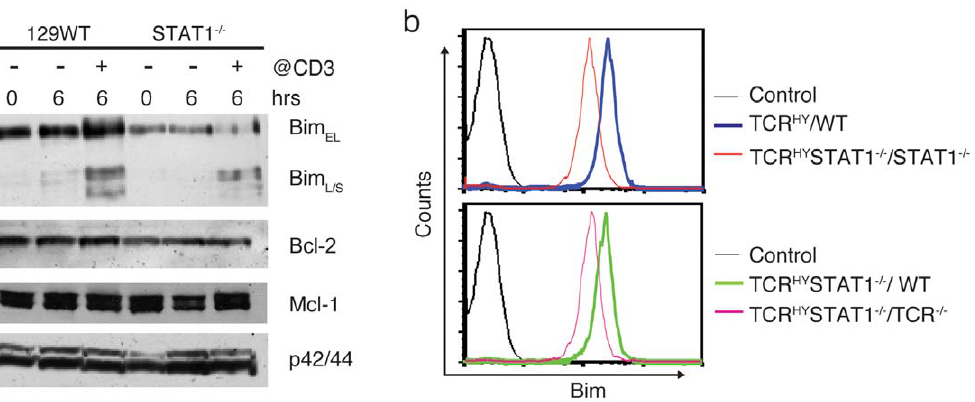
Figure 5. Bim expression correlates with altered elimination of STAT1-deficient thymocytes. ( a ) Immunoblot analysis of Bcl family members in WT and STAT1 2 / 2 thymocytes. Cells were isolated from thymi of WT and STAT1 2 / 2 mice and cultured in the presence or absence of plate bound anti-CD3 (10 m g/ml). Following 6 hr incubation cells were lysed, subjected to SDS-PAGE and analyzed by immunoblot for the indicated proteins. Lysates were also prepared from freshly isolated thymocytes without further incubation (lanes 1 and 4). Data is representative of at least three independent experiments. ( b ) Flow cytometric analysis of intracellular Bim expression levels in thymocytes from chimeric mice. Chimeric mice were generated as described in Fig. 4, and Bim expression in TCR HY -gated thymocytes was determined by intracellular staining using flow-cytometry.